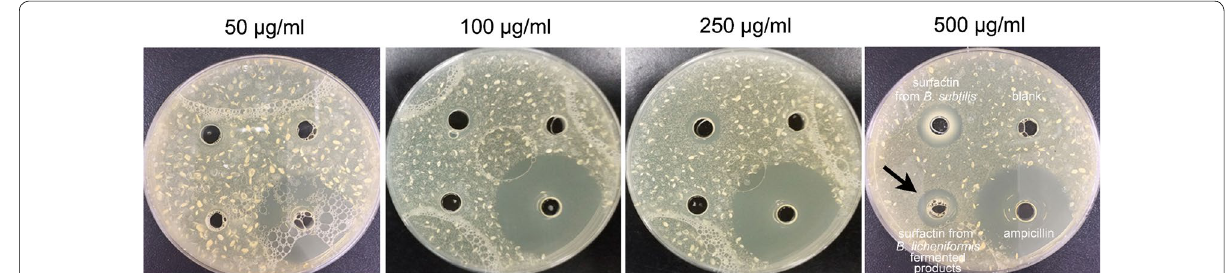
Fig. 6 Growth inhibitory zone of surfactin against C. perfringens using agar‑well diffusion assay. C. perfringens were grown in the different concentrations (50, 100, 250, 500 μg/ml) of the surfactin produced from B. subtilis (top left) and B. licheniformis ‑fermented products (bottom left), blank (top right), and ampicillin (bottom right) for 24 h. The black arrow indicates the inhibition zone. Three experiments were conducted, and one representative result is presented